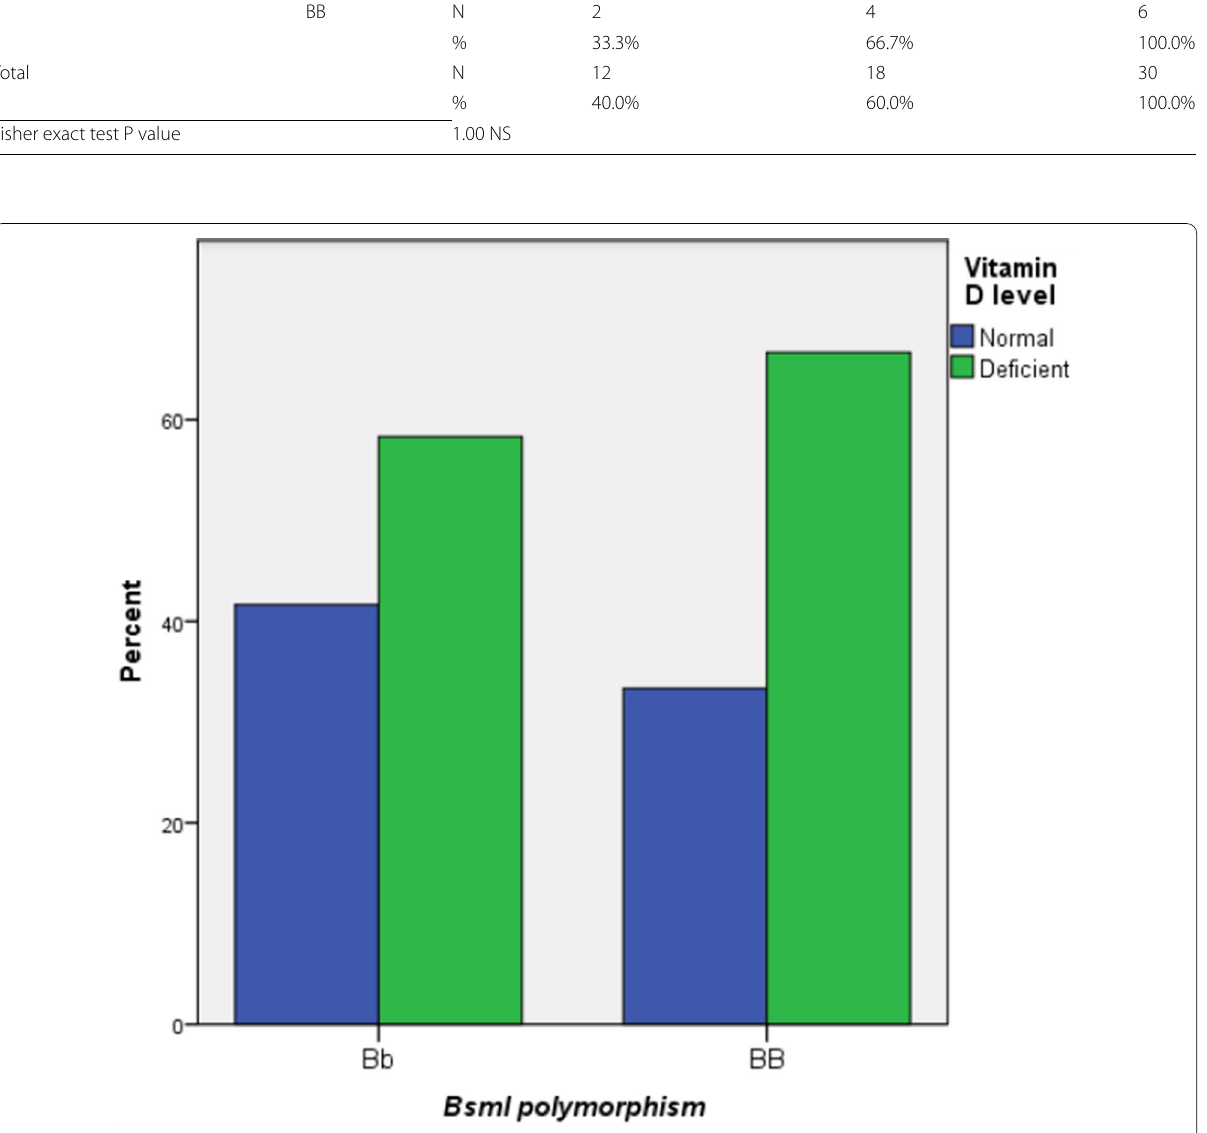
Fig. 1 BsmI gene polymorphism among male obese students with deficient and nondeficient vitamin D